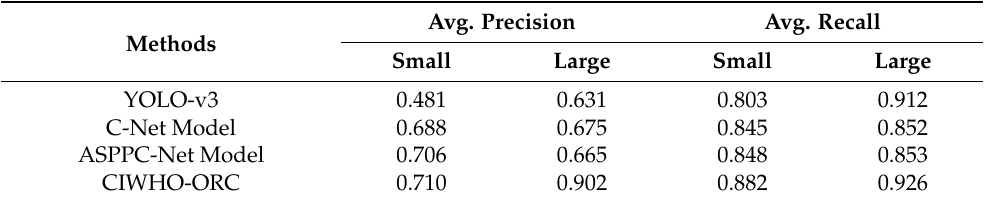
Table 4. APE and ARE Analysis of CIWHO-ORC technique on Small and Large Object